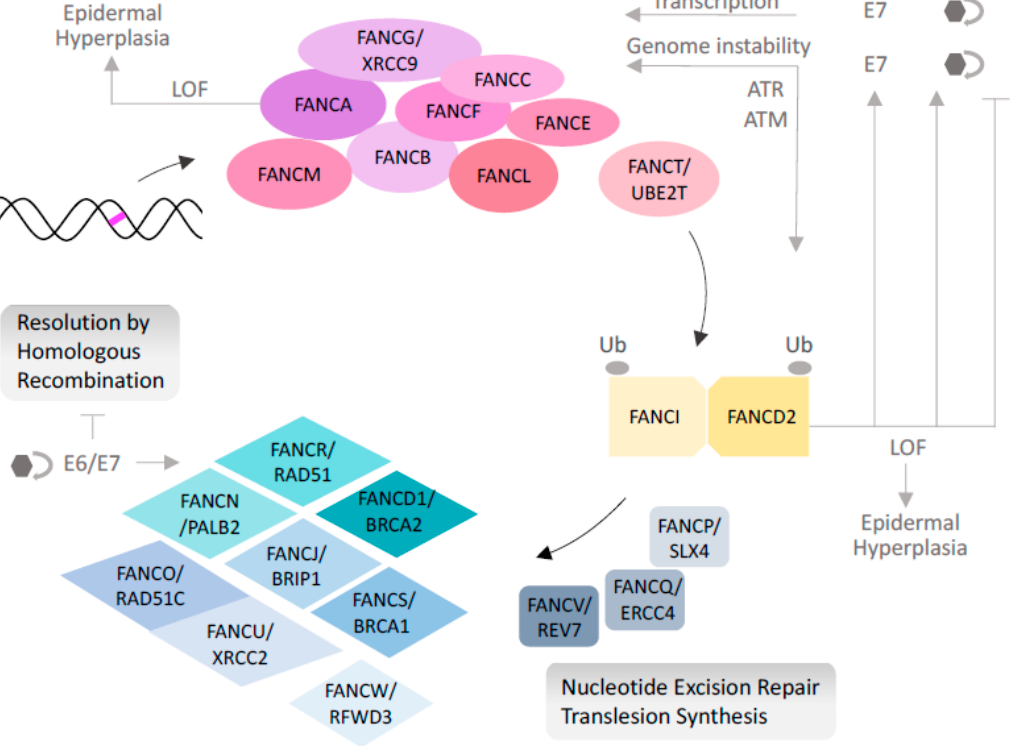
Figure 1. Only the classical role of the Fanconi anemia (FA) pathway in the repair of interstrand cross-links (ICLs) is depicted, which involves highly coordinated protein–DNA and protein–protein interactions in the nucleus. Other reported functions of the FA pathway in replication stabilization, origin firing, and cytokinesis are not shown, but are reviewed in detail in [22]. In response to ICL formation, the FA core complex (pink circles), including Fanconi Anemia Complementation Group (FANC) A (FANCA), assembles near the lesion, and this activation drives the ubiquitination, by